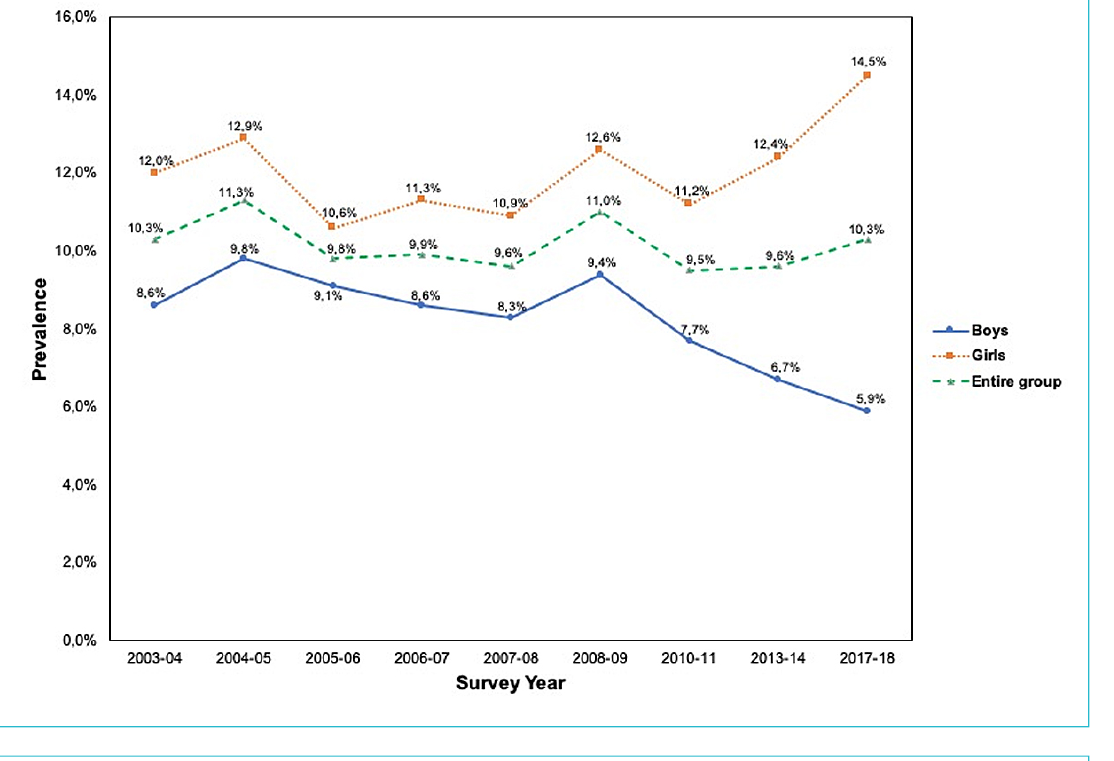
Figure 1: Trends in the prevalence of overweight among Geneva children aged 5–6 years between 2003–04 and 2017–18 by gender.